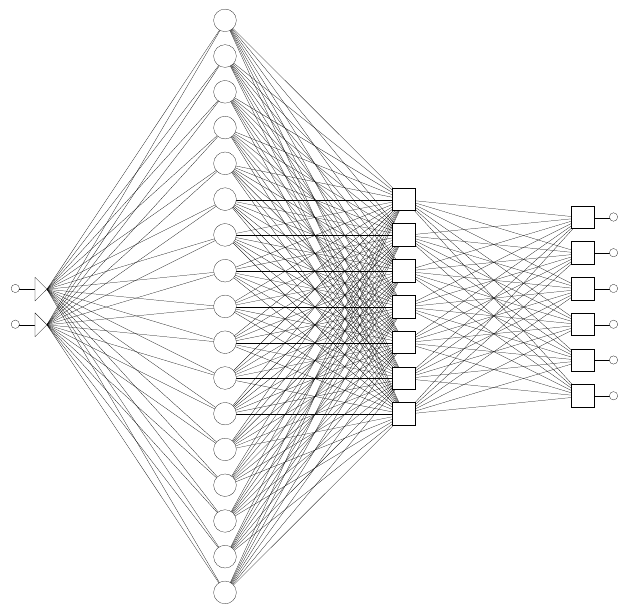
Figure 11. Schematic representation of the used GRNN (generalized regression neural